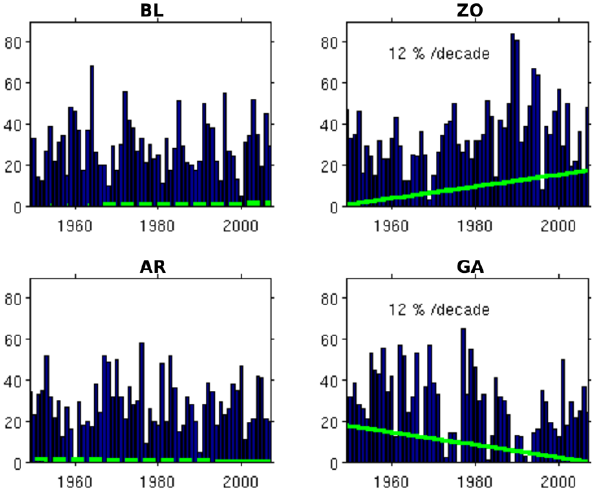
Fig. 5. Trends in the frequencies of observed LAR for the 59years of the NCEP reanalysis (1948–2007). As before first row, BL (left), ZO (right), second row, AR (left), GA (right).